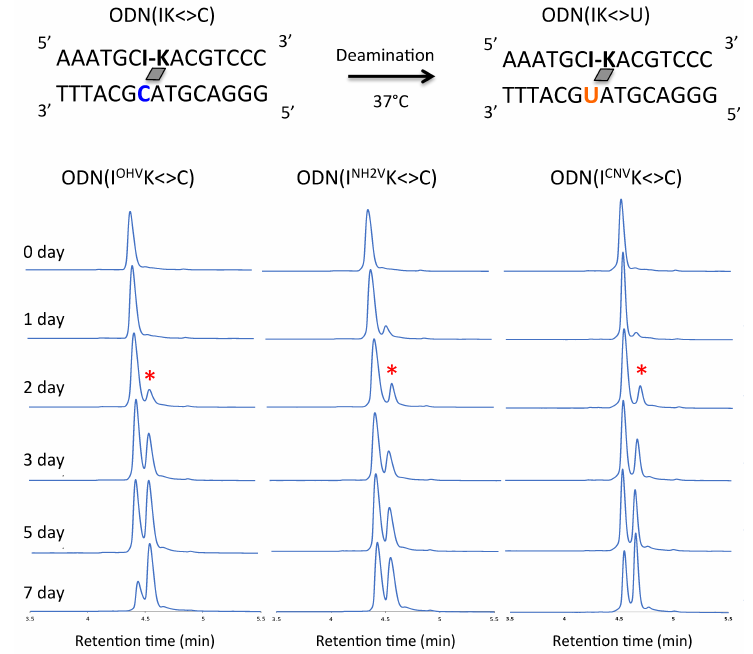
Figure 2. Polyacrylamide gel electrophoresis (PAGE) analysis of the mixture of ODN(XK) and Cy3-modified cODN(C) after photo-cross-linking using various times. [ODN] = 10 µ M in 50 mM sodium cacodylate buffer (pH 7.4) containing 100 mM NaCl. Photoirradiation at 366 nm was performed at 4 ◦ C. Ultra-high performance liquid chromatography (UPLC) chromatograms for photo-cross-linking are shown in Figure S1.